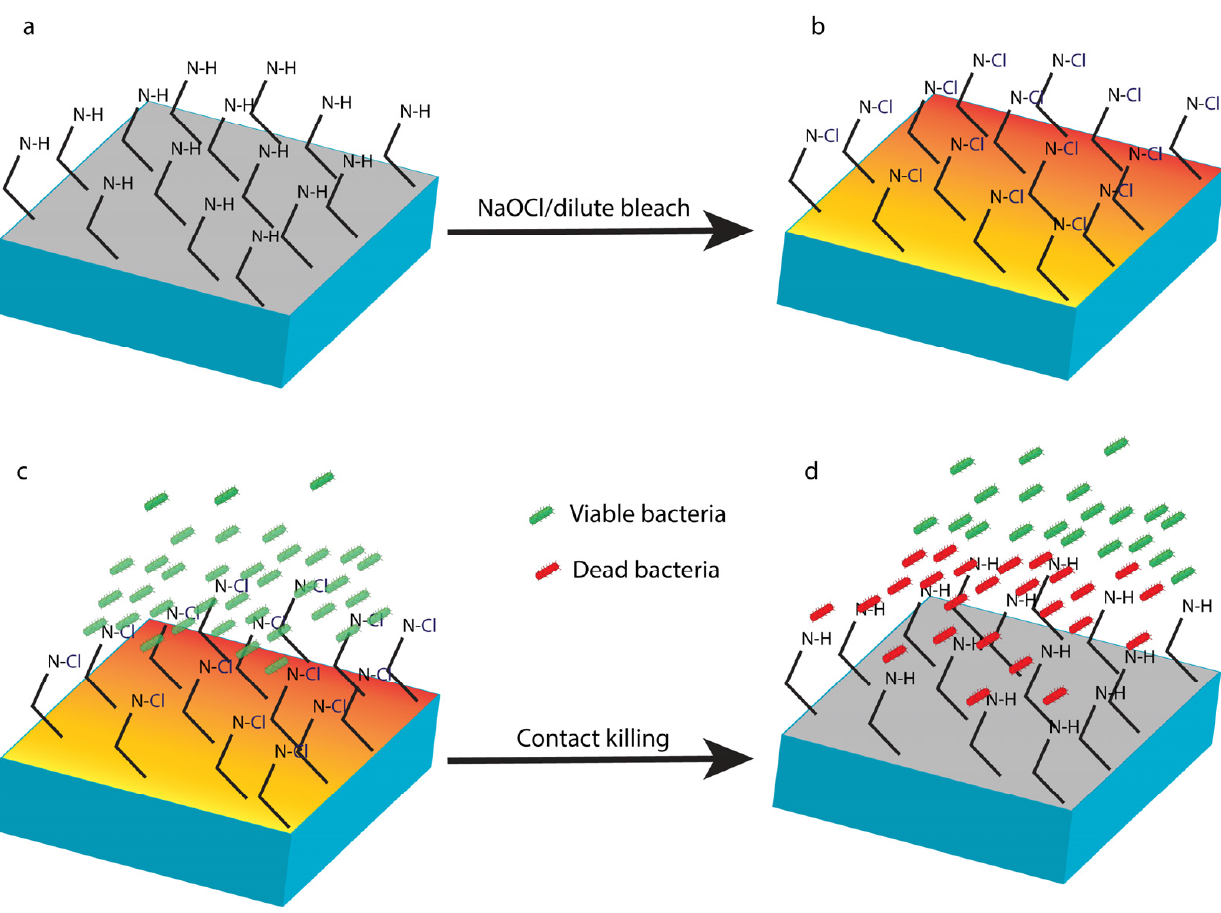
Figure 6 . N ‐ halamine coatings. A coating with a polymeric N ‐ halamine precursor with >N ‐ H func ‐ Figure 6. N-halamine coatings. A coating with a polymeric N-halamine precursor with >N-H tionalities on the surface (a) undergoes functionalisation of the surface amine groups with a dilute ‐ functionalities on the surface ( a ) undergoes functionalisation of the surface amine groups with a bleach solution or NaOCl solution to form biocidal >N ‐ Cl groups (b). Live bacteria encounter the dilute-bleach solution or NaOCl solution to form biocidal >N-Cl groups ( b ). Live bacteria encounter surface (c) and are killed upon contact with >N ‐ Cl groups (d), noting that after killing, the surface the surface ( c ) and are killed upon contact with >N-Cl groups ( d ), noting that after killing, the surface returns to (a) and becomes inactive until the next recharge cycle. returns to ( a ) and becomes inactive until the next recharge